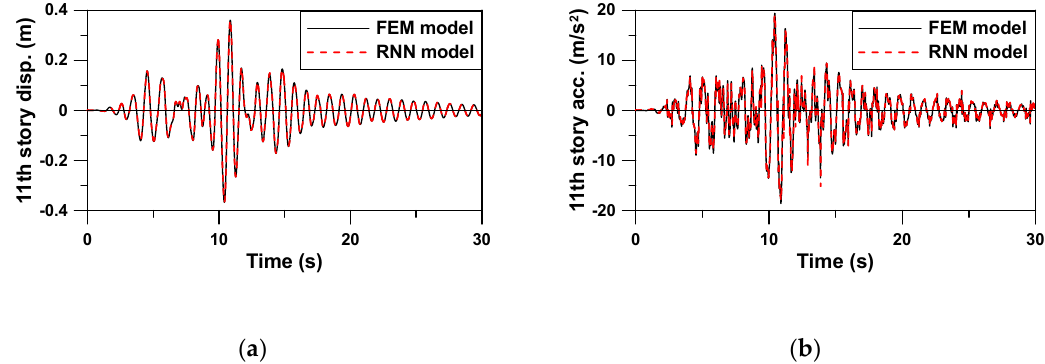
Figure 8. Comparison of the time history responses of Example 1 between FEM and RNN models (EQ No. 11): ( a ) Displacement time history; ( b ) Acceleration time history. Figure 9. Comparison of time history responses of Example 1 between FEM and RNN models (EQ No. 12): ( a ) Displacement time history; ( b ) Acceleration time history.